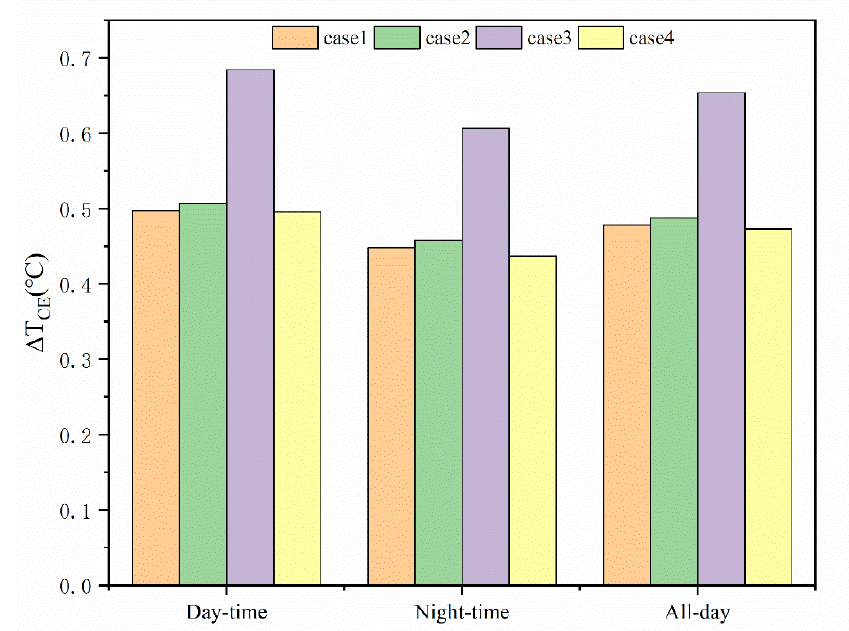
Figure 6. Day ‐ time, night ‐ time, and all ‐ day cooling effects in cases 1, 2, 3 and 4. Figure 6. Day-time, night-time, and all-day cooling effects in cases 1, 2, 3 and